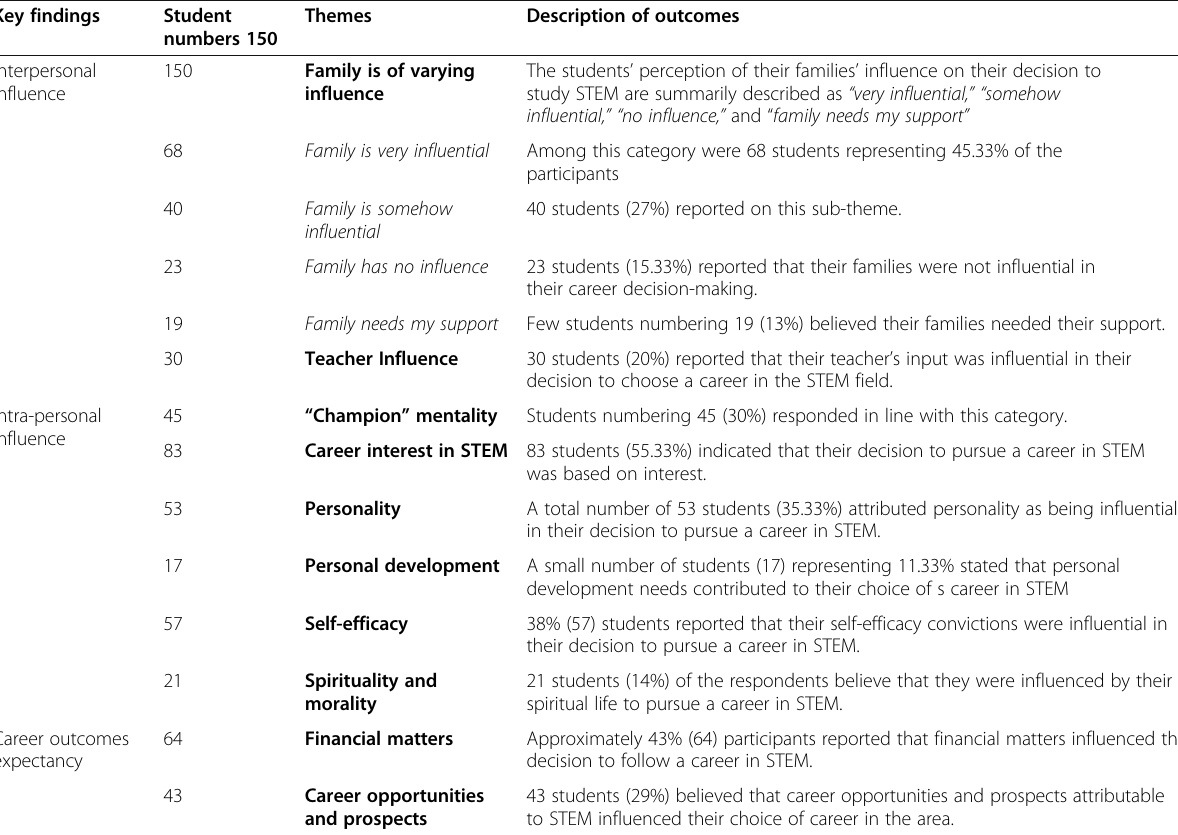
Table 1 STEM Students ’ description of the factors underlying their career decision-making Key